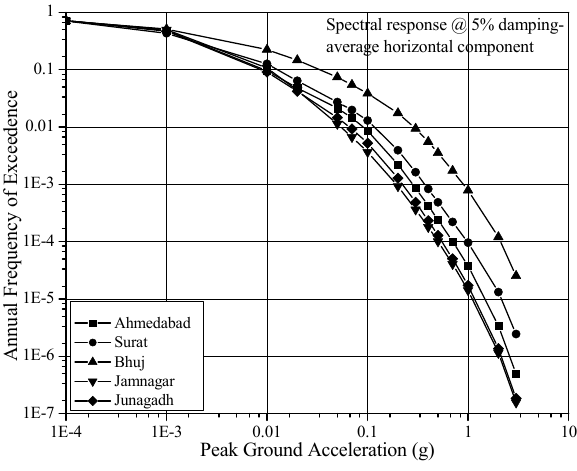
Fig. 11. Total Hazard calculated for various cities at zero spectral Figure 11. Total Hazard calculated for various cities at zero spectral period i.e. PGA 4 period i.e.